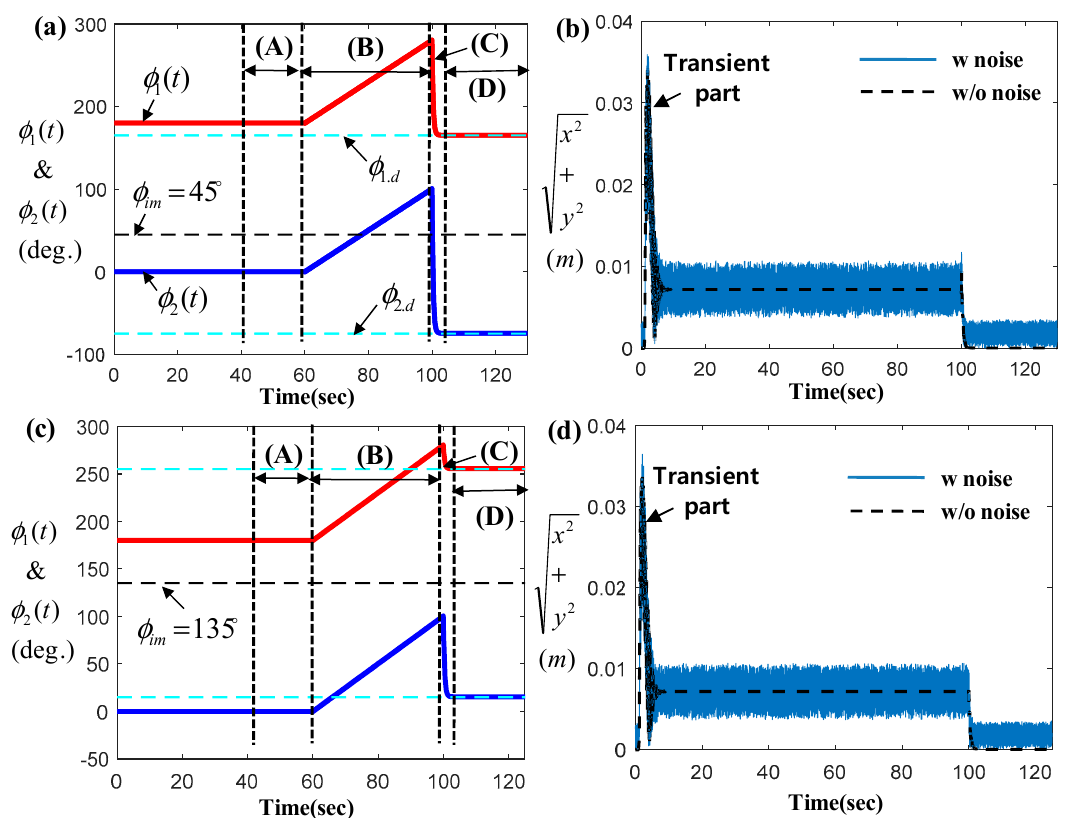
Figure 7. Estimations and angular position control of AAEMS (LQR-based optimal control only ( a ) and ( c ) indicate the angular position of AAEMS and ( b ) and ( d ) are the vibration amplitudes of rotor).